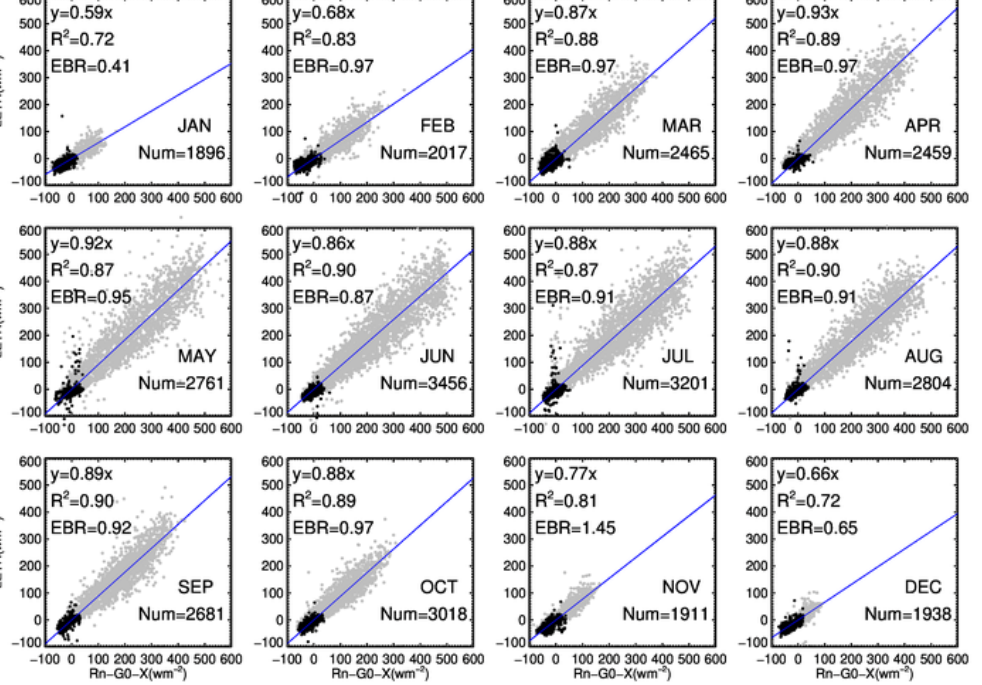
Figure 2. All years combined monthly scatter plot of the half-hourly averages of the available energy (Rn − G0 − X) versus the turbulent fluxes (LE + H). Rain and snow periods are discarded because of malfunctioning of the instruments during these events.